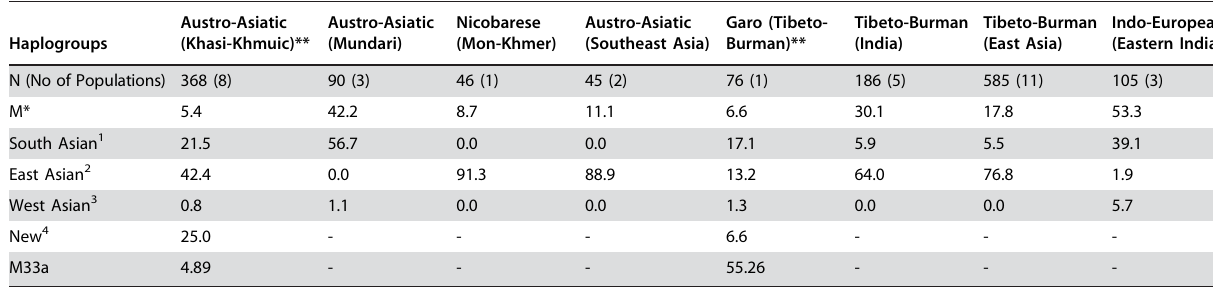
Table 6. mtDNA haplogroup frequencies in different linguistic populations of South and Southeast Asia. .. ... .... ... ... .... ... ... .... ... ... .... ... ... .... ... ... .... ... ... .... ... ... .... ... ... .... ... ... .... ... ... .... ... ... .... ... ... .... ... ... .... ... ... .